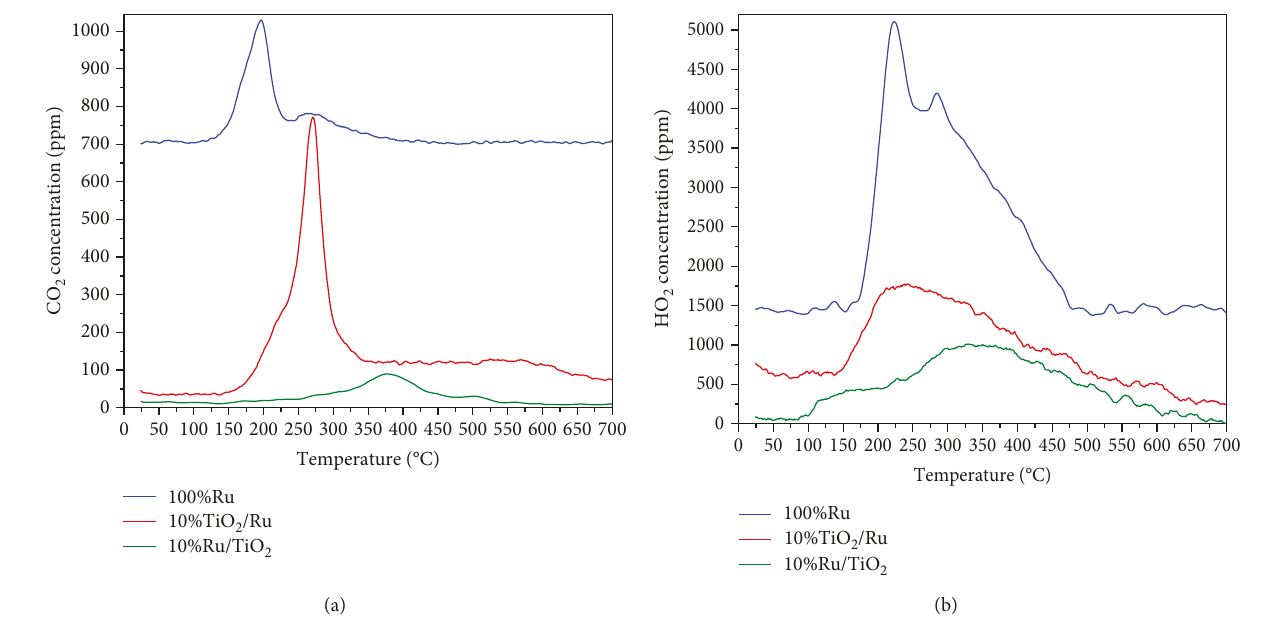
Figure 3: Displaced TPD pro fi les of (a) CO